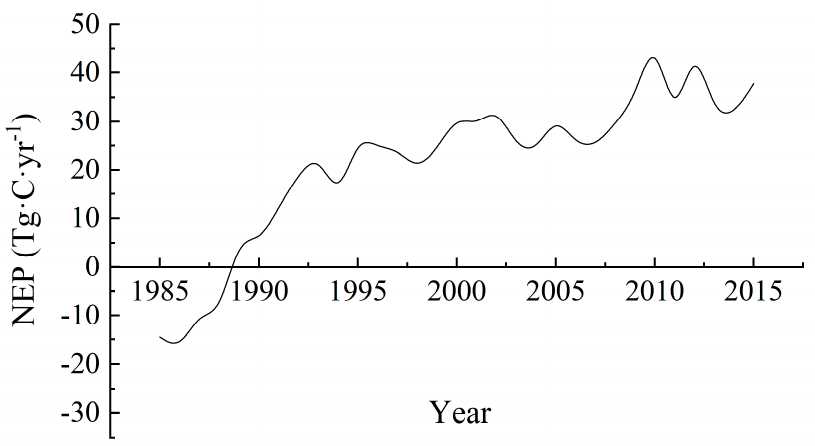
Figure 6. The time series of NEP of forests in the Zhejiang Province simulated by the InTEC model during 1985–2015.